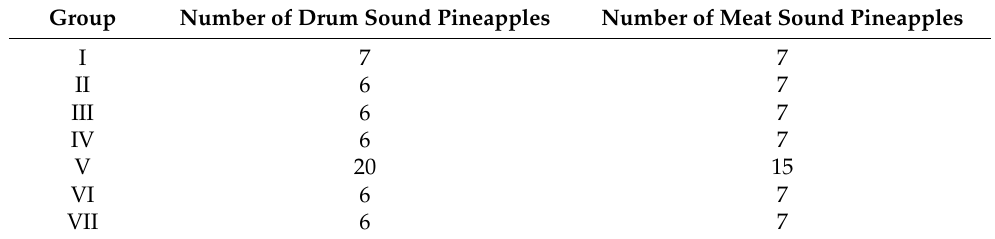
Table 4. Number of pineapples.